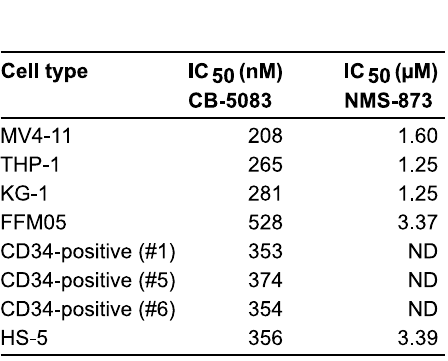
PLOS ONE | https://doi.org/10.1371/journal.pone.0266478 April 6,